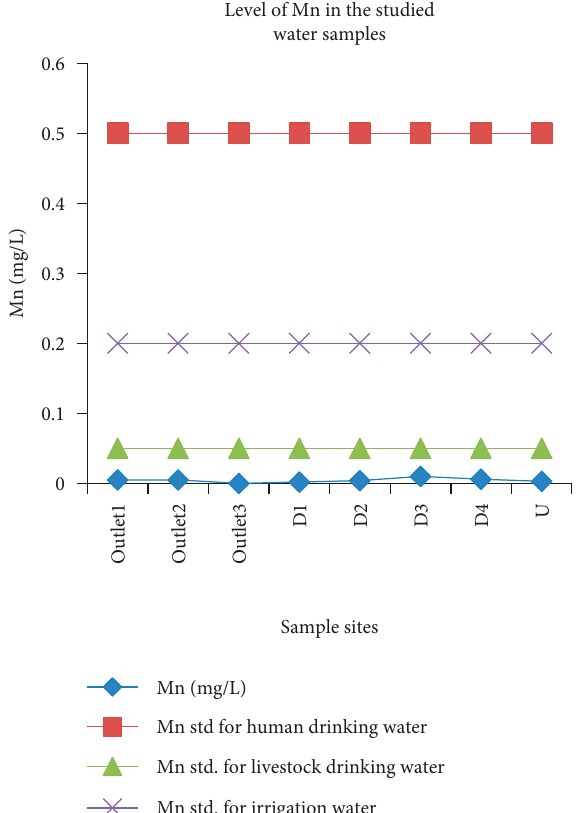
Figure 12: Comparison of the manganese concentration in wastewater discharged from the Zenzelma campus and the rec- ommended limits of manganese.